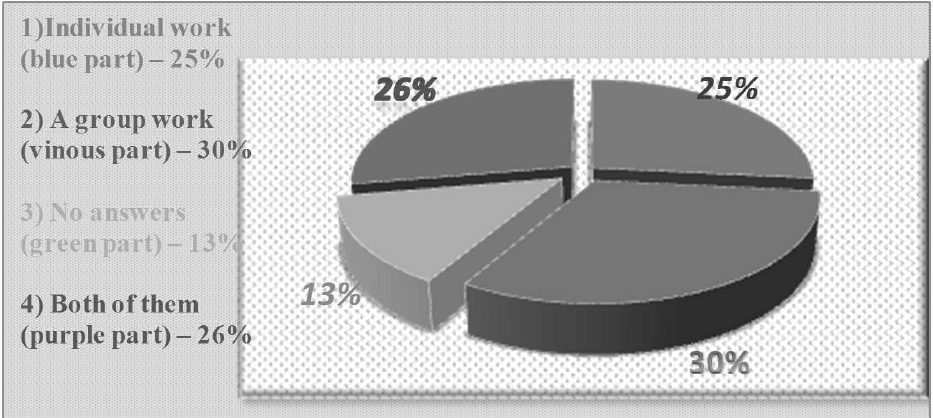
Fig.1. The pie-chart diagram is to identify the percentages of each preferred